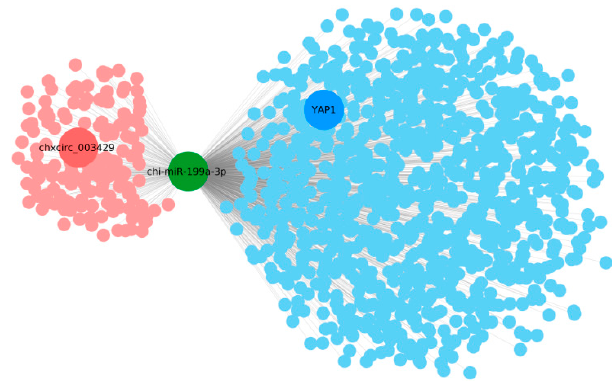
Figure 5. Circ003429-miR-199a-3p- YAP1 interaction analysis.